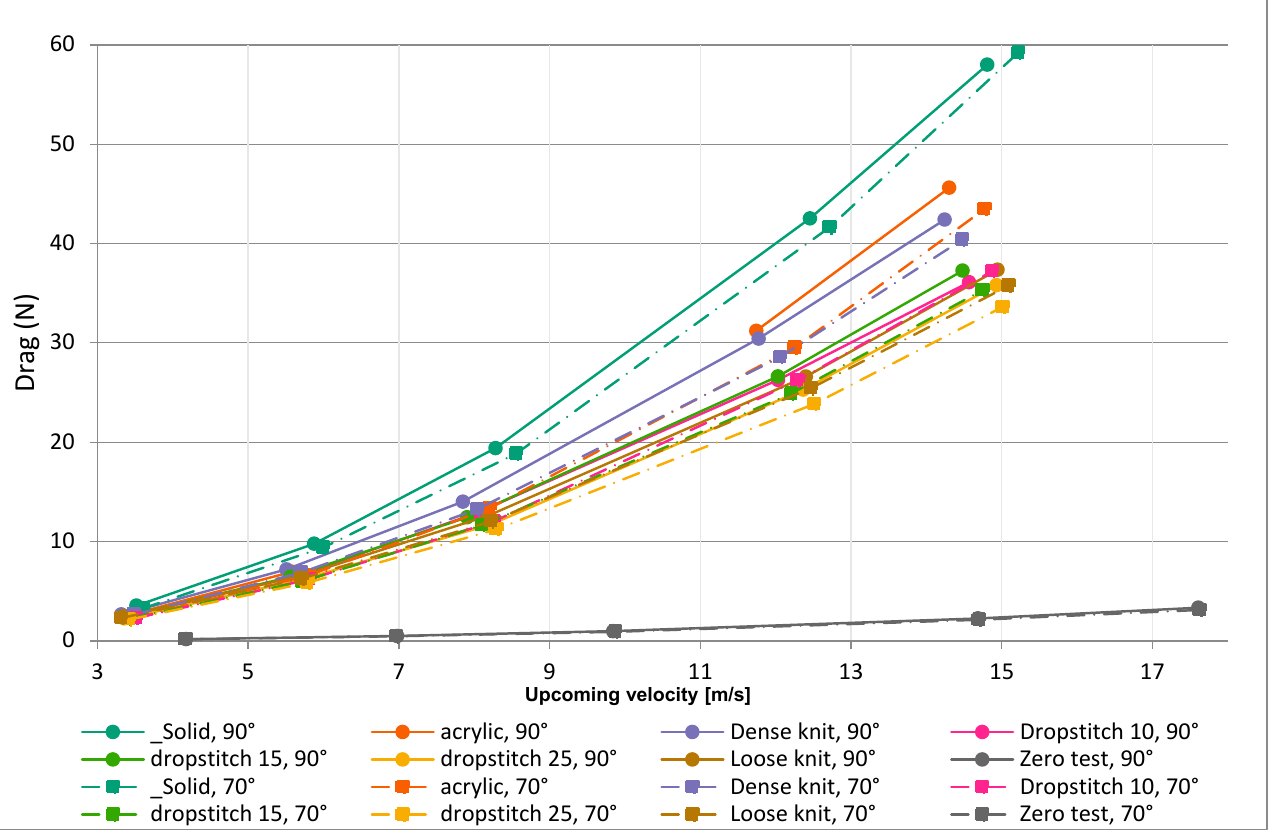
Figure 17. Drag force exerted on the models during the wind tunnel tests. The results show concern models positioned at 90° and 70° toward the wind direction.